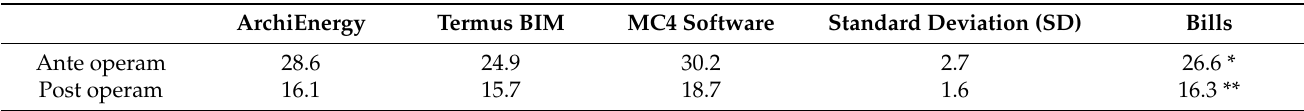
Table 5. Energy diagnosis results (kWh/m 2 y): software